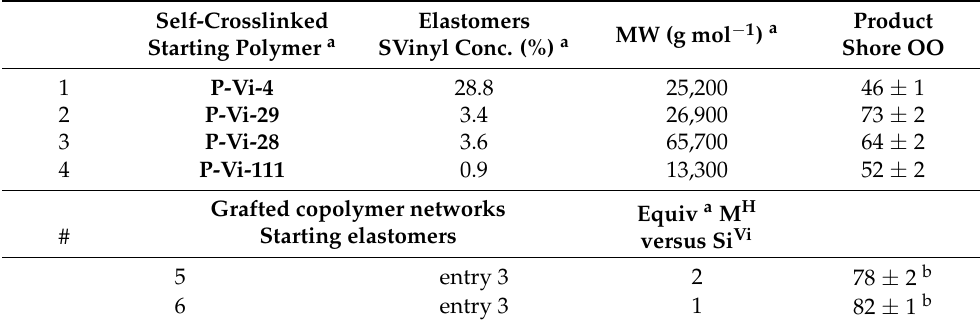
Table 2. The synthesis of silicone elastomers using hydride-terminated, well-defined vinyl silicones via